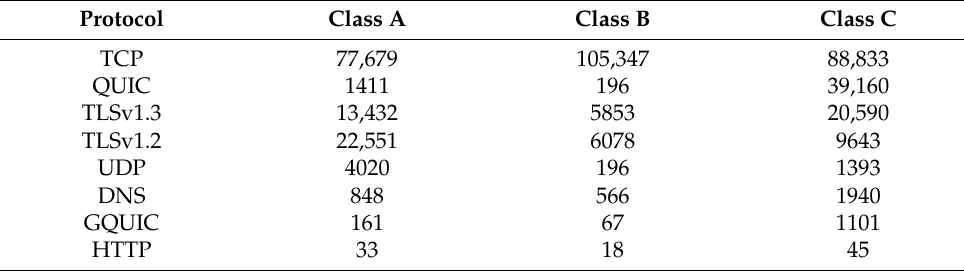
Table 6. Network protocol distribution according to class.